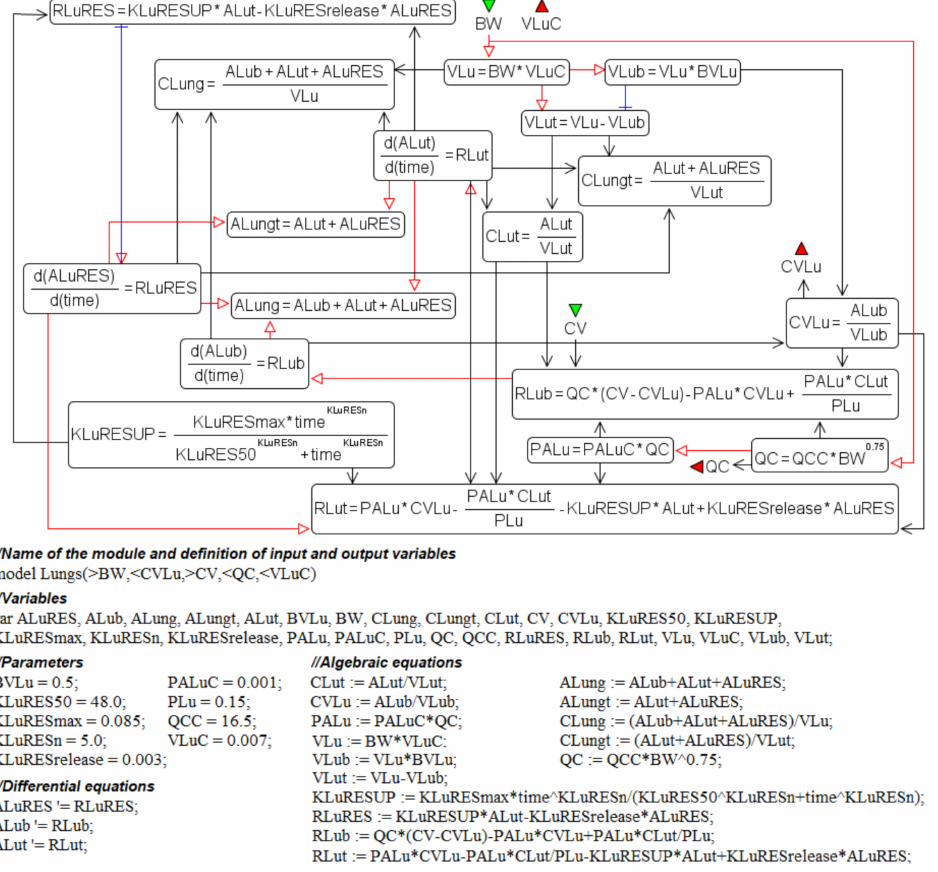
Figure 6. A diagram of the lung compartment automatically generated in BioUML using Antimony text